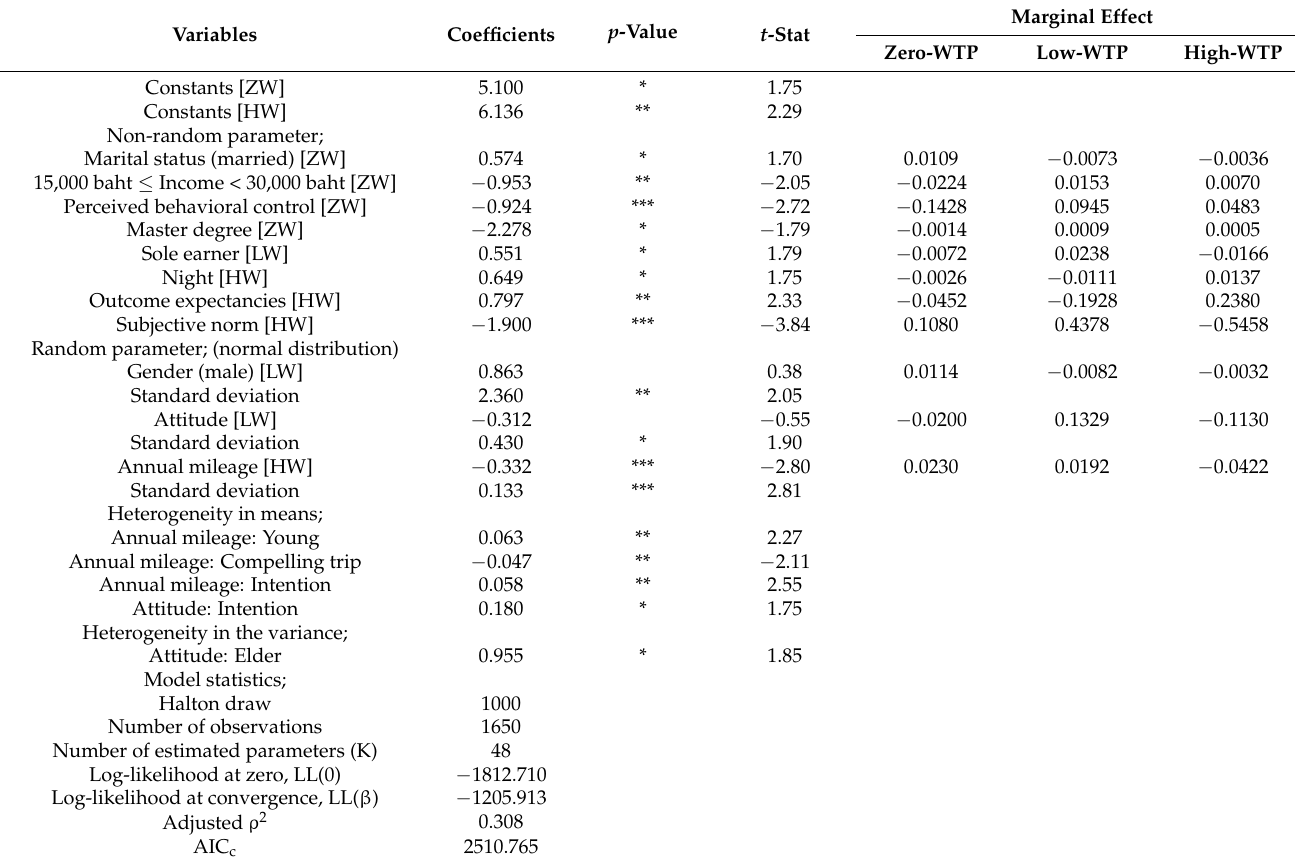
Table 6. Model results of random parameter logit model with heterogeneity in means and